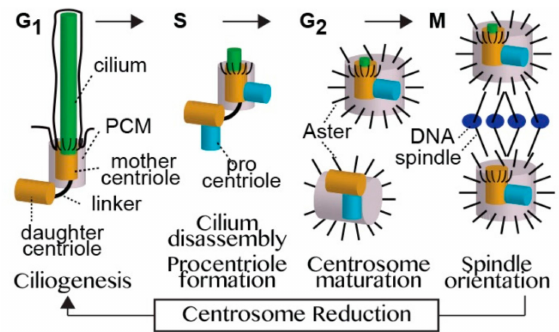
Figure 4. A model of the centriole cycle. Cells have two centrioles: the mother centriole and daughter centriole. The two centrioles have distinct roles in controlling cilium number, and in some cell types, in the outcome of asymmetric cell division. The mother centriole is the older of the two centrioles and is compositionally and structurally fully developed (mature). However, its function differs depending upon the present stage of the cell cycle. When a cell is in G1 phase, the mother centriole is enveloped by a thin layer of pericentriolar material (PCM) and assembles a cilium. In S phase, the cilium disassembles and the mother centriole forms a new centriole (the procentriole). In G2 phase, the mother centriole recruits the PCM, which nucleates and anchors microtubules to form an aster. In M phase, the mother centriole participates in the formation and localization of one of the mitotic spindle poles. After the completion of cell division, each centriole pair becomes a mother and a daughter centriole for one of the two daughter cells, and the mother centriole loses most of its PCM and astral microtubules through a process known as centrosome reduction. The daughter centriole is the younger of the two centrioles, and is compositionally, structurally, and functionally immature. When the cell is in S phase, the daughter centriole forms a procentriole. In G2 phase, the daughter separates from its mother, recruits PCM, forms an aster, and then forms the second centrosome. In M phase, the daughter centriole participates in the formation and localization of the second mitotic spindle pole, and after cell division becomes a mother centriole for one of the daughter